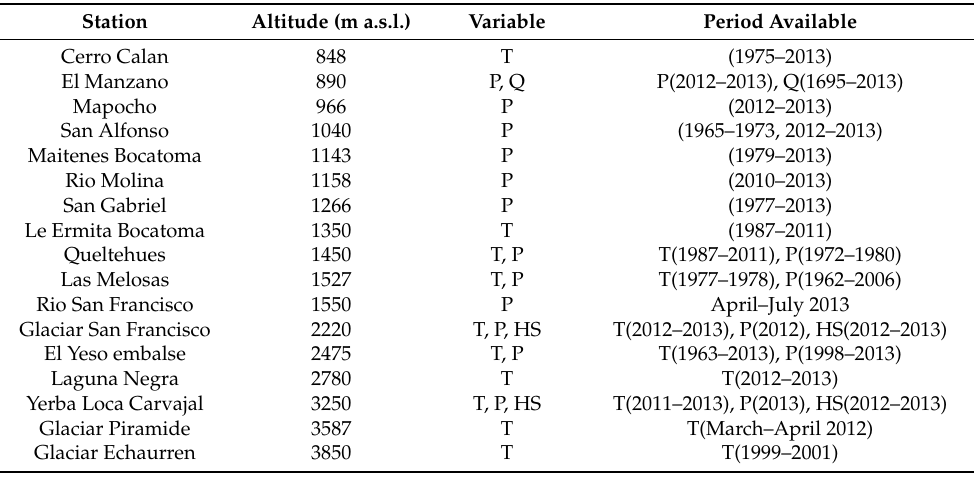
Table 1. Weather and hydrometric stations available. Measured variables are temperature T, precipitation P, snow depth HS, discharge Q. See Figure 1 for location.